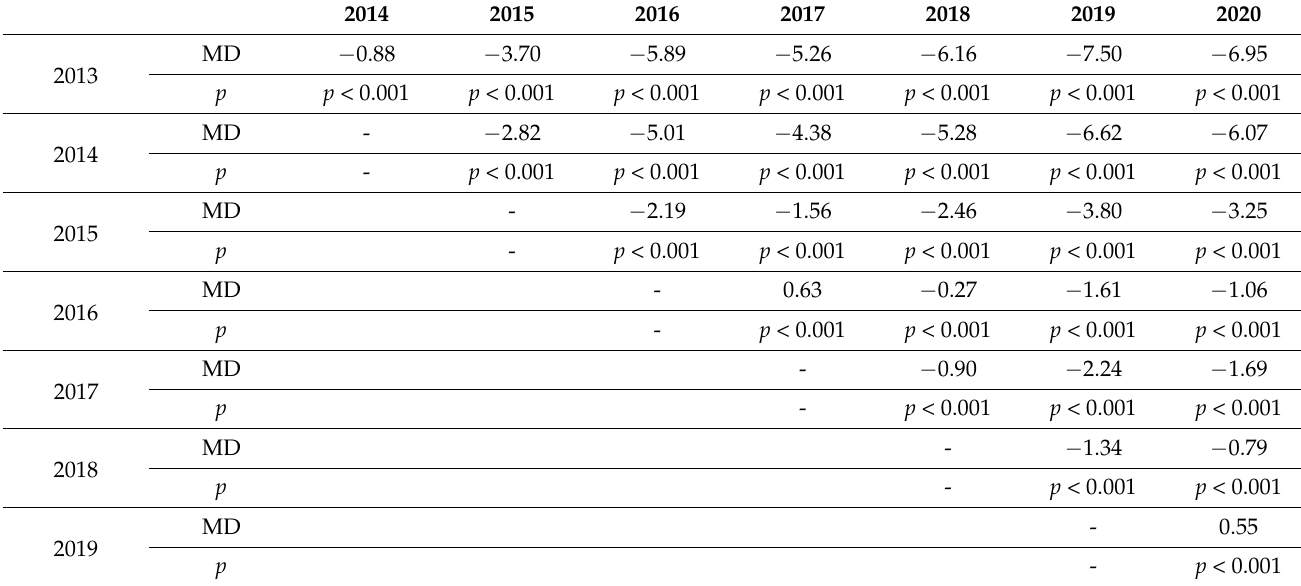
Table 5. Comparison of no pulse checking in the case of VF and asystole between individual editions of the